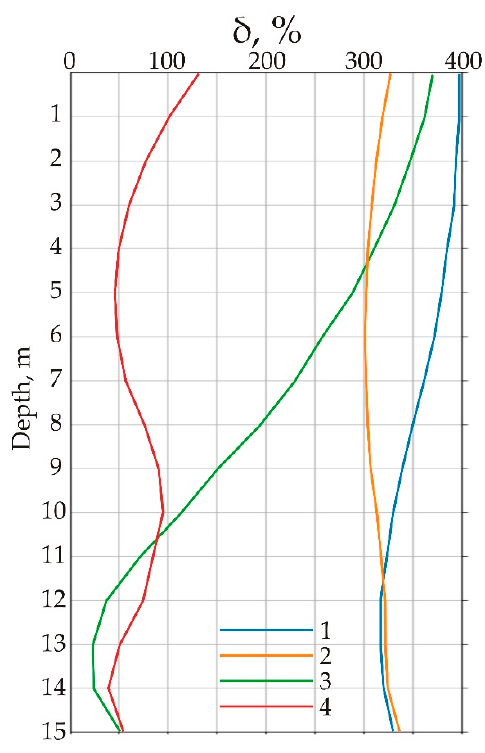
Figure 7. Relative differences (%) between the electromotive force in the reference model and those with a talik at the times t 1 = 2 ∙ 10 − 7 s and t 2 = 10 − 6 s. Key: 1 is small talik at t 1 , 2 is large talik at t 1 , 3 is small talik at t 2 , 4 is large talik at t 2 .